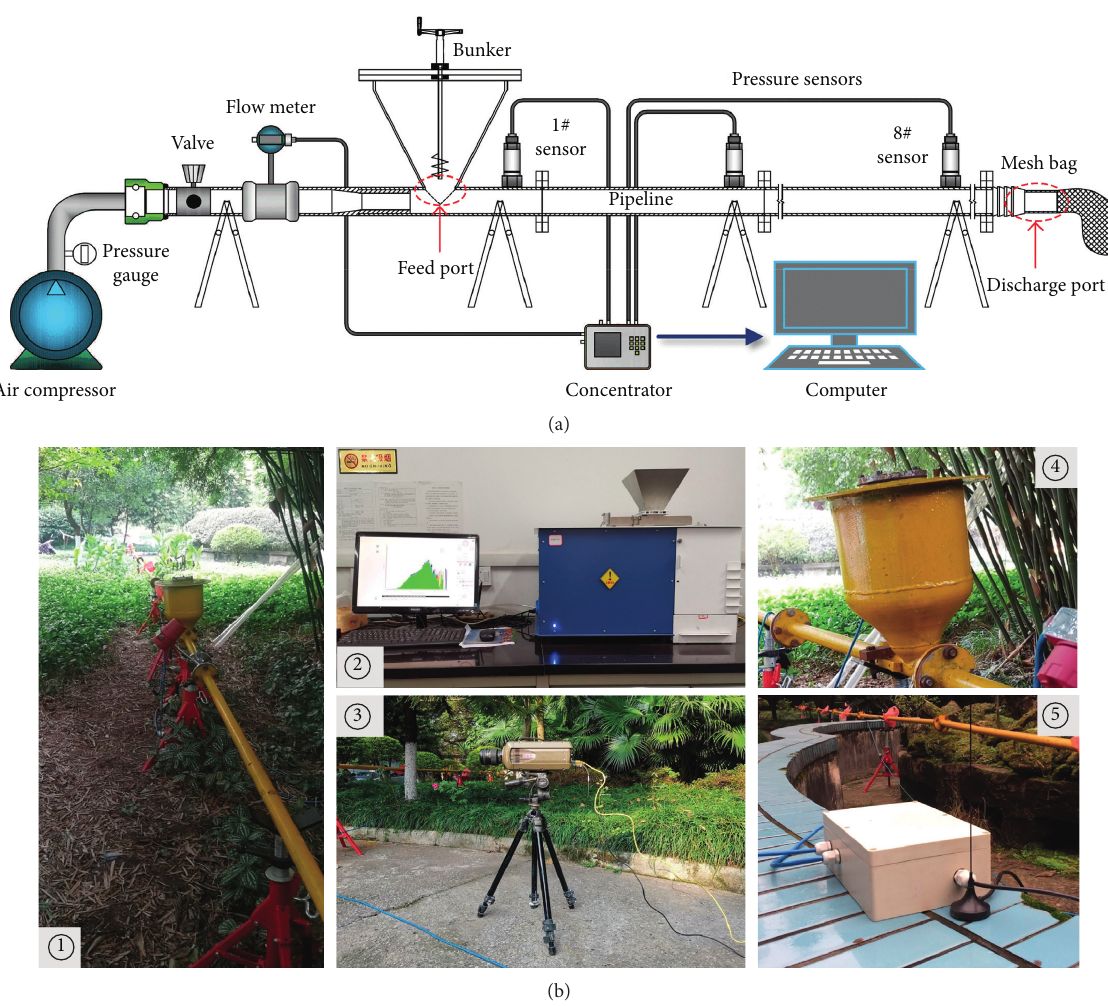
Figure 1: The experimental system. (a) Schematic diagram of the experimental system. (b) Physical map of the experimental system: ① Conveying pipeline. ② Particle analyzer. ③ High-speed camera. ④ Bunker. ⑤